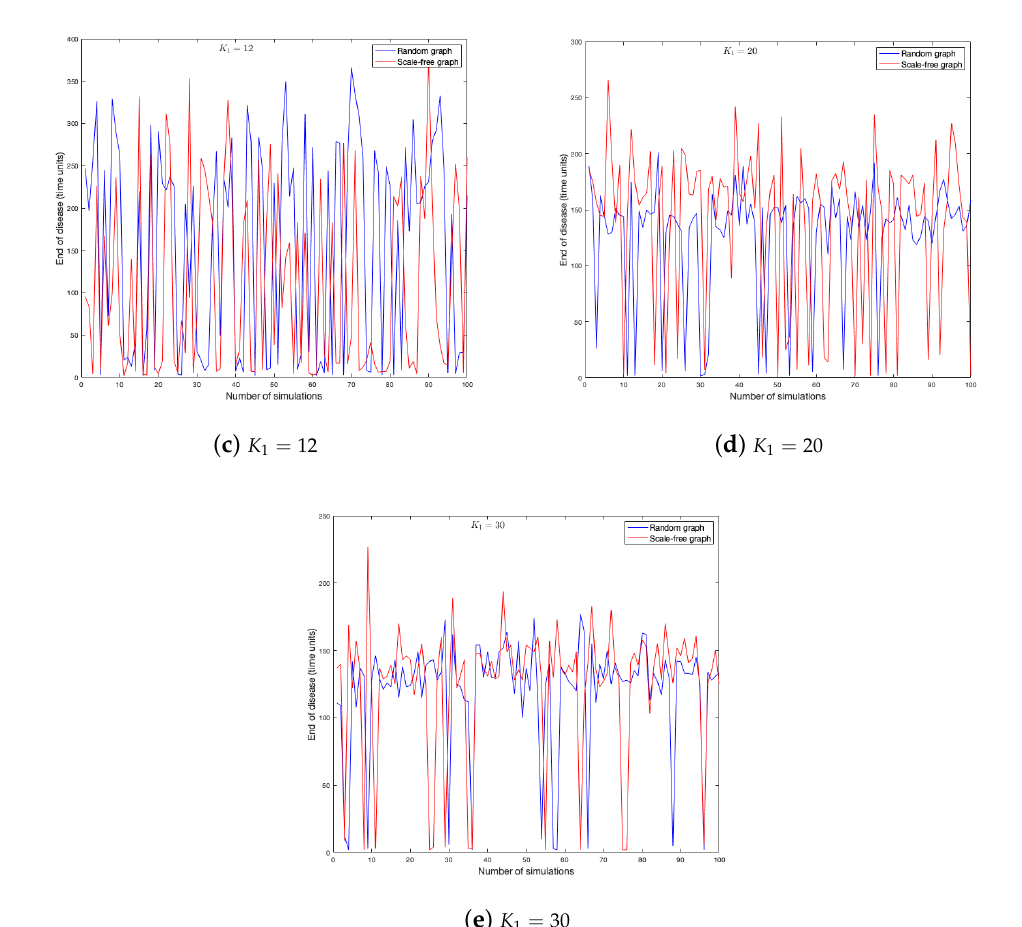
Figure 11. End of disease for different K 1 in random and scale-free graph.